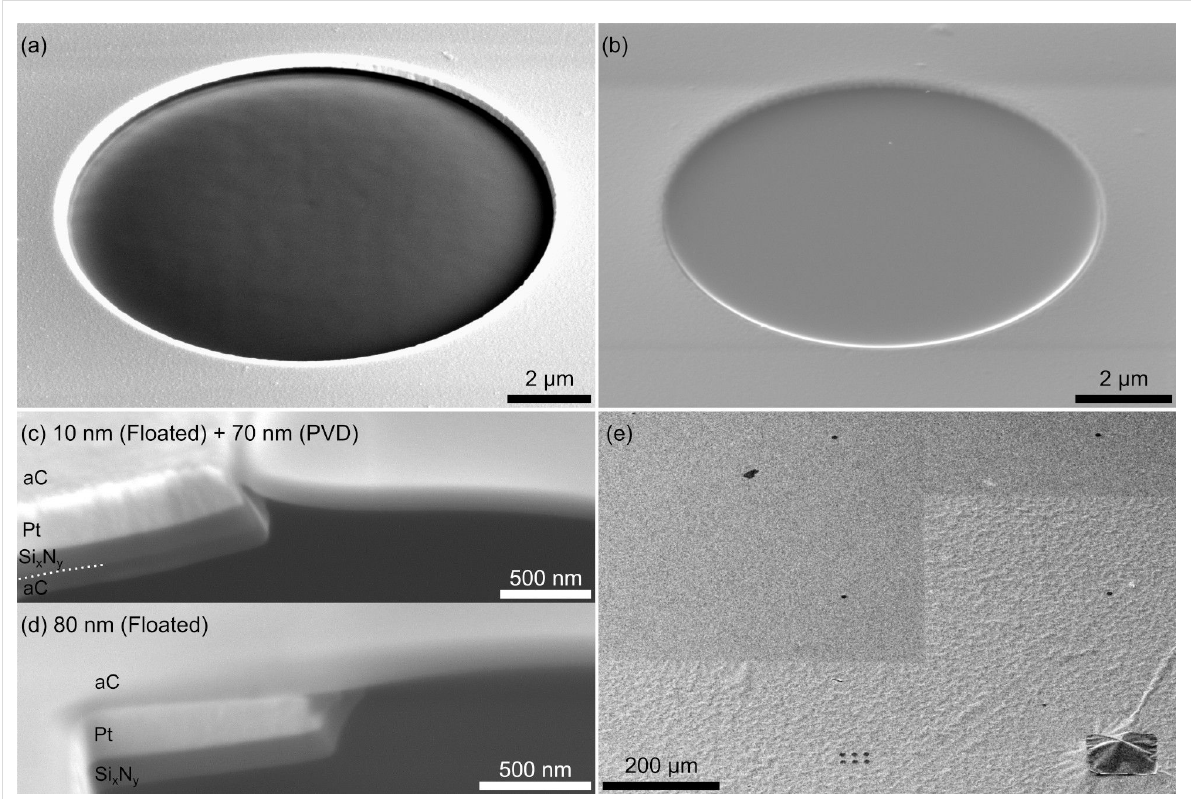
Figure 3: SEM images of (a) FIB-prepared and (b) floated aC thin films reveal a smoother surface for the latter. (c) The cross-section SEM image at the aperture edges reveals sagging of a floated thin film (10 nm) after additional deposition of 70 nm aC. (d) Floating of a comparably thick 80 nm aC film results in more stability at the aperture edge. (e) Delamination of floated aC films is visible in the bottom half of the SEM image. FIB scanning over relatively large areas flattens the film, which is visible in the top part. The straight edges of the FIB scanning windows are clearly